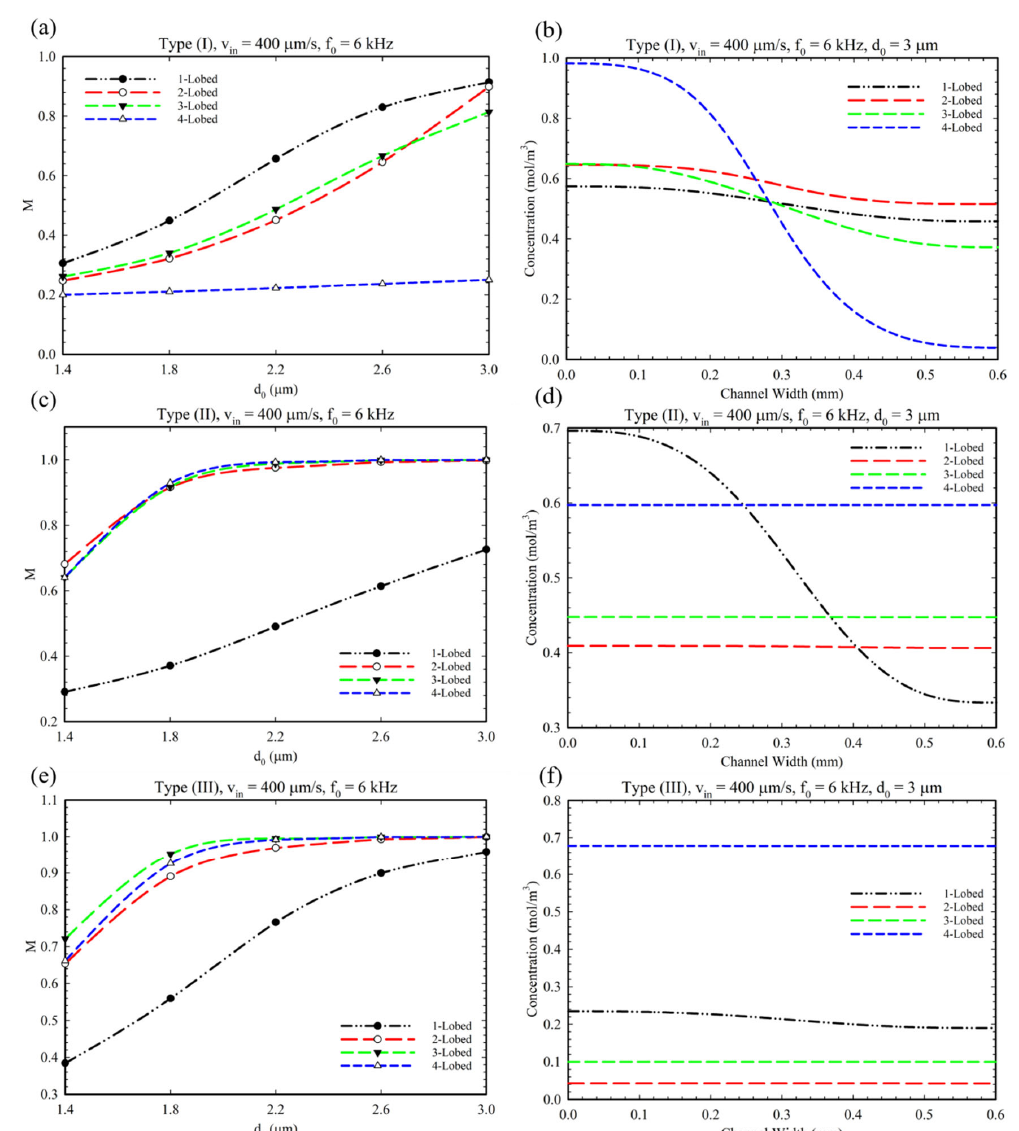
Figure 9. ( a , c , e ) The effect of the oscillation amplitude on the mixing for multi-lobed structures in Type I, II, and III configurations. ( b , d , f ) The related concentration profile at the microchannel outlet considering the effect of the change in the oscillation amplitude.